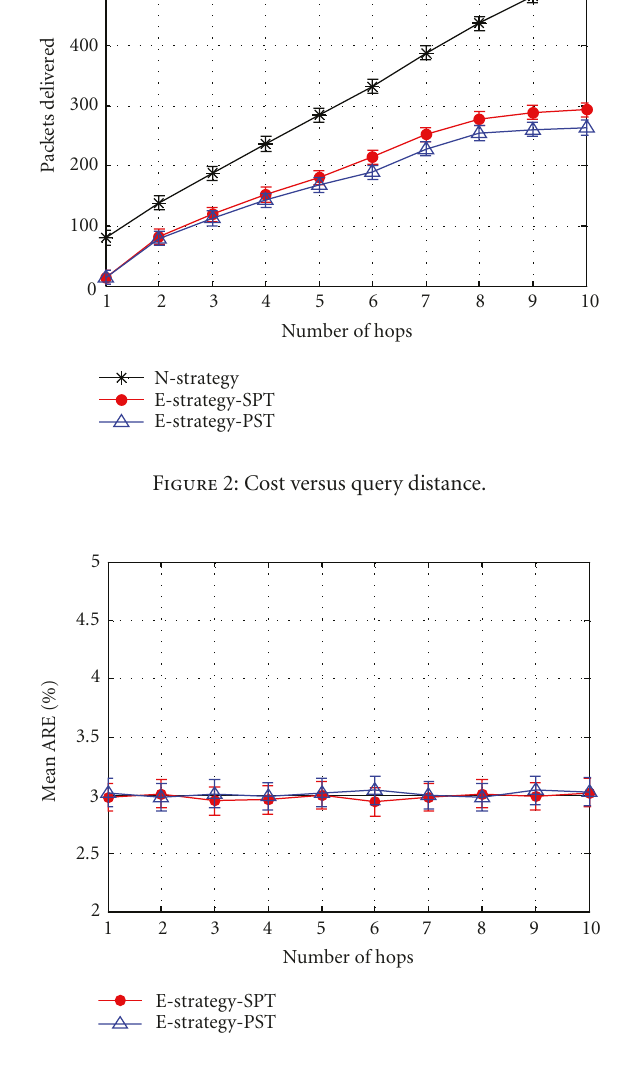
Figure 3: Accuracy versus query distance.